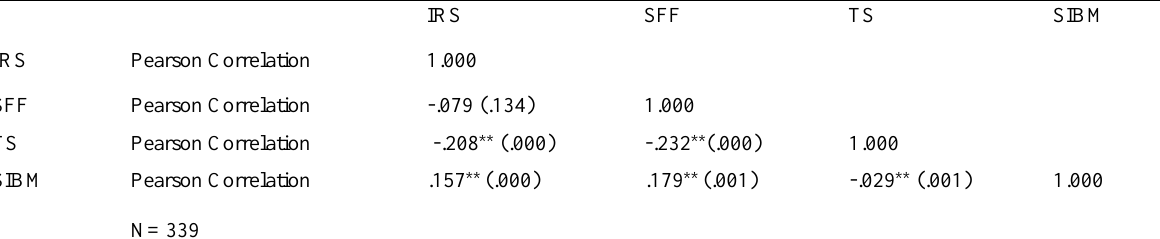
Table 3: Correlational analysis